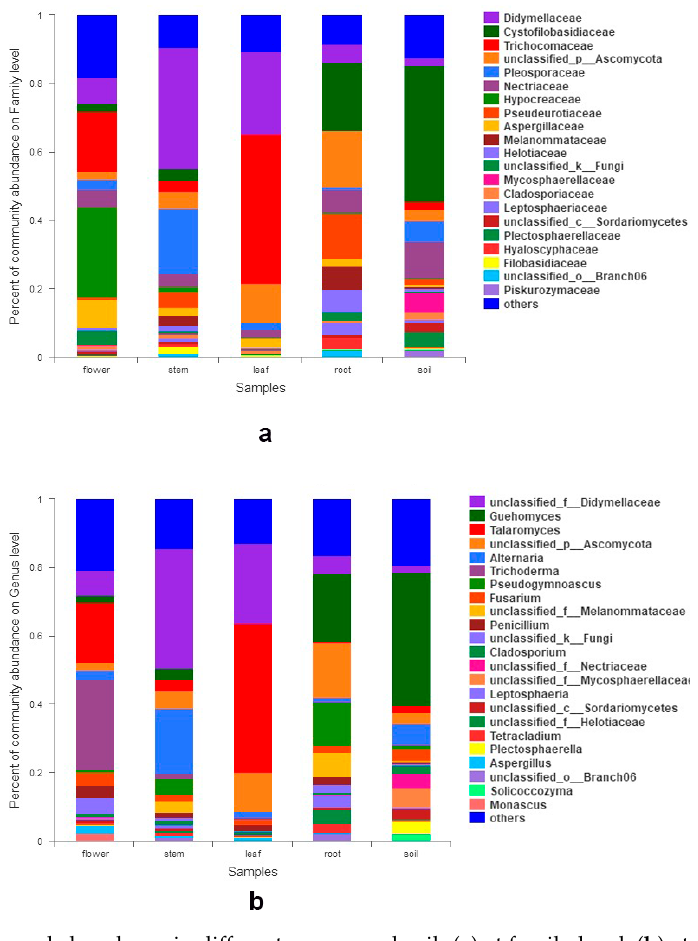
Figure 2. Fungal abundance in different organs and soil: ( a ) at family level; ( b ) at genus level.